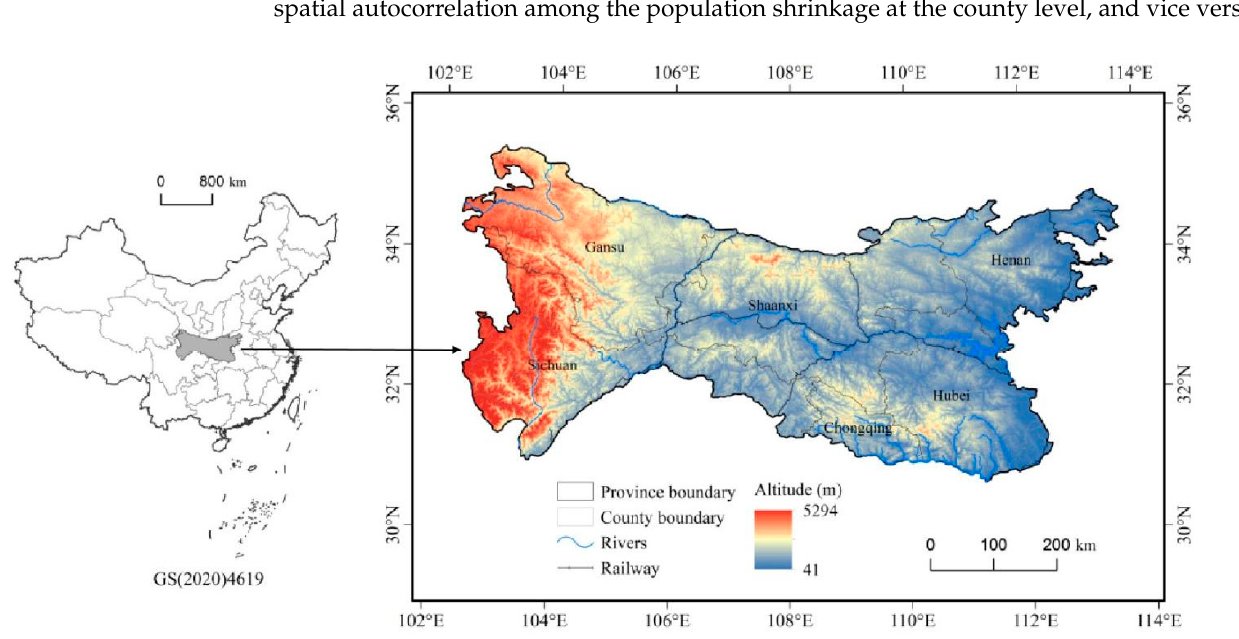
Figure 1. Location of the North–South Transitional Zone of China.